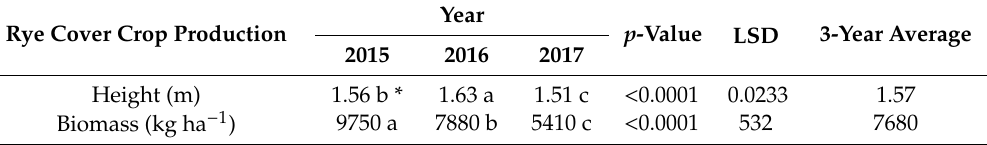
Table 3. Cereal rye biomass production and height in three growing